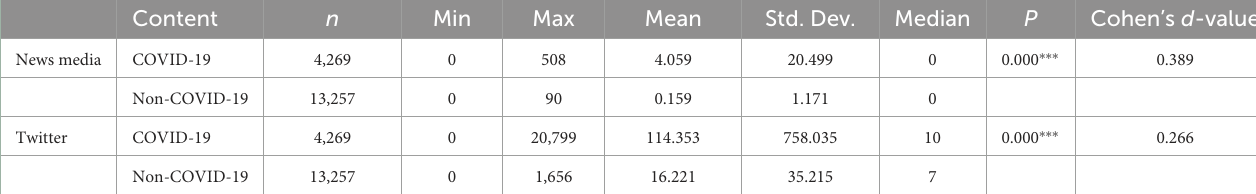
TABLE 4 Altmetric score for COVID-19-related preprints and non-COVID-19-related preprints in news media and Twitter.